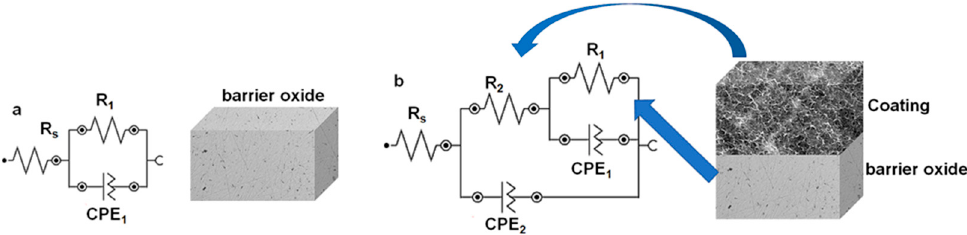
Figure 5. Equivalent circuits used to fit EIS data: ( a ) for Ti50Zr substrate; and ( b ) coated samples.